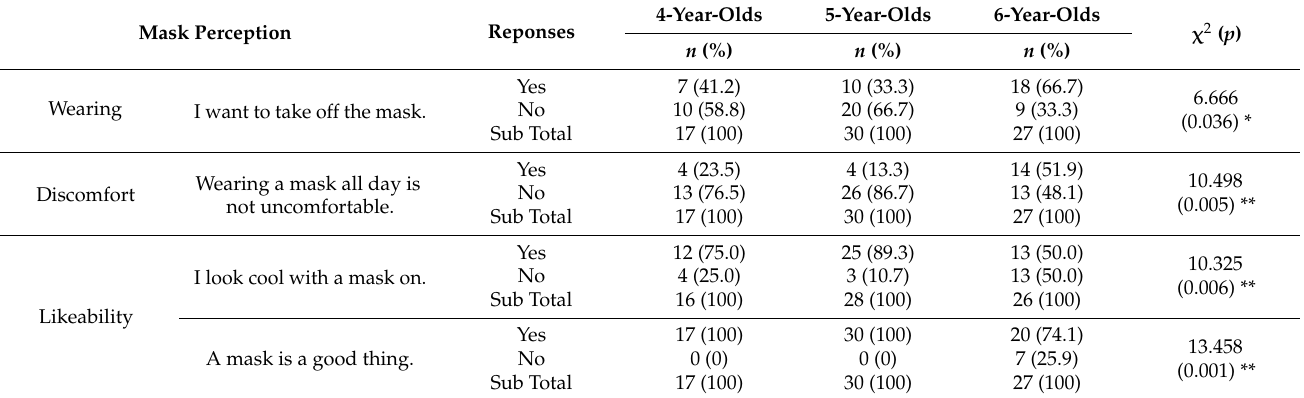
Table 4. Children’s results with a significant age difference (*: p < 0.05, **: p < 0.01). Mask